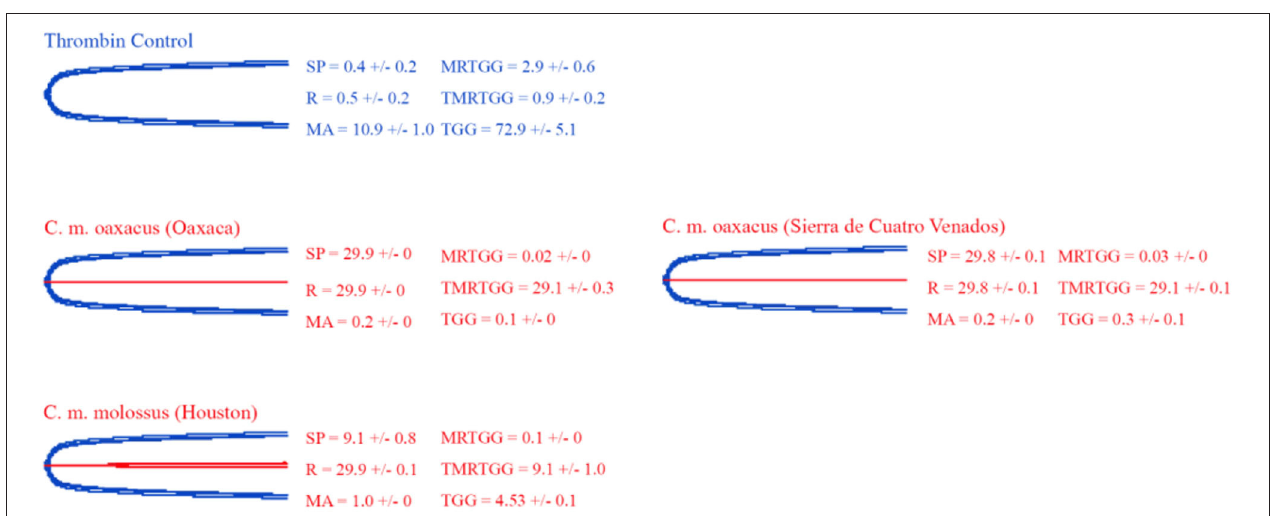
FIGURE 7 | Thromboelastography traces showing the coagulation pattern of human fibrinogen incubated with venoms of three C. molossus specimens of two subspecies ( C. m. molossus and C. m. oaxacus ). Venom traces are shown in red, thrombin control traces in blue. SP, split point (min); R, time (min) to minimum detectable clot (2mm); MA, maximum amplitude (mm); MRTGG, maximum rate of thrombus generation (dynes/cm 2 ); TMRTGG, time to maximum thrombus generation (min); TGG, total thrombus generation (dynes/cm 2 ). Results shown as n = 4 mean ± SD.